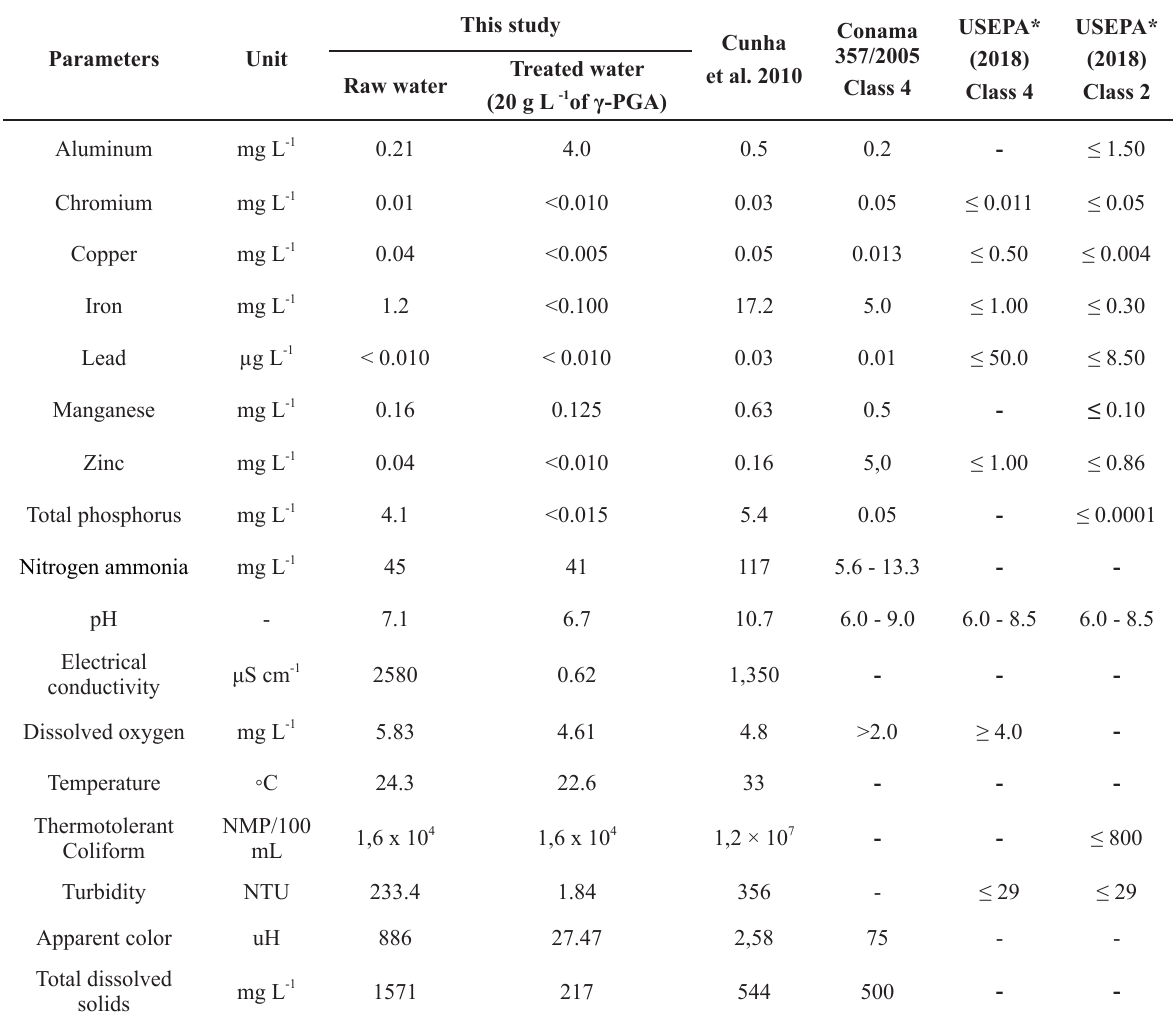
Physicochemical parameters of raw and treated water from the Pinheiros River in the dry